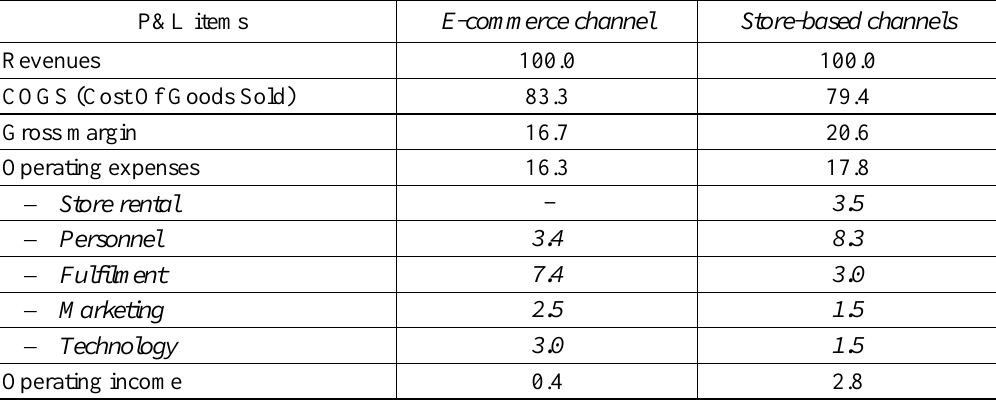
Table 3: E-commerce versus store-based grocery retailers P&L (%,